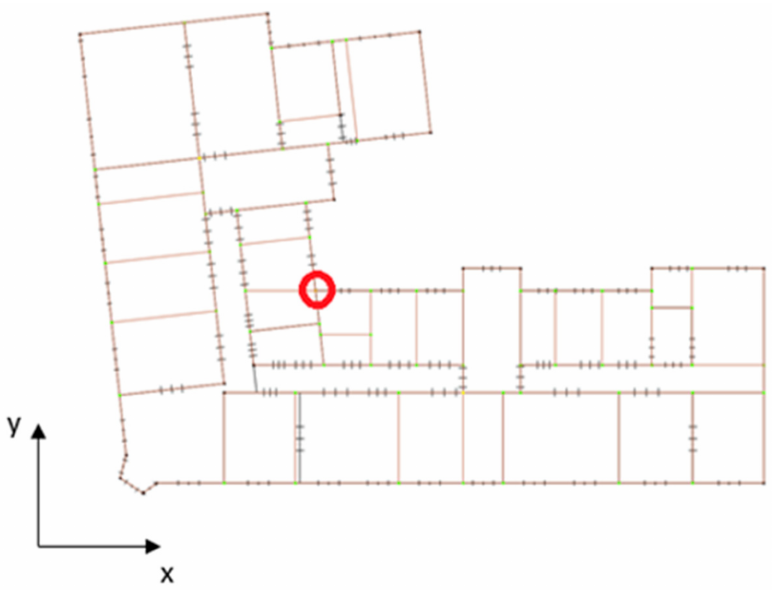
Figure 15. Position of the approximated center of masses on the 3rd floor–3Muri12 software.